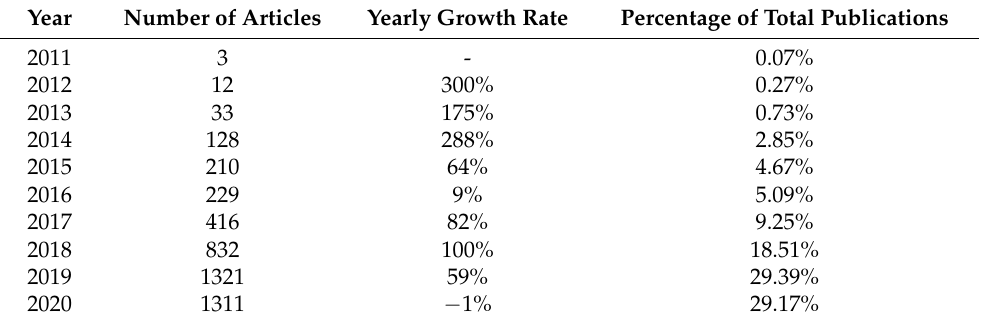
Table 2. Number of publications by year.